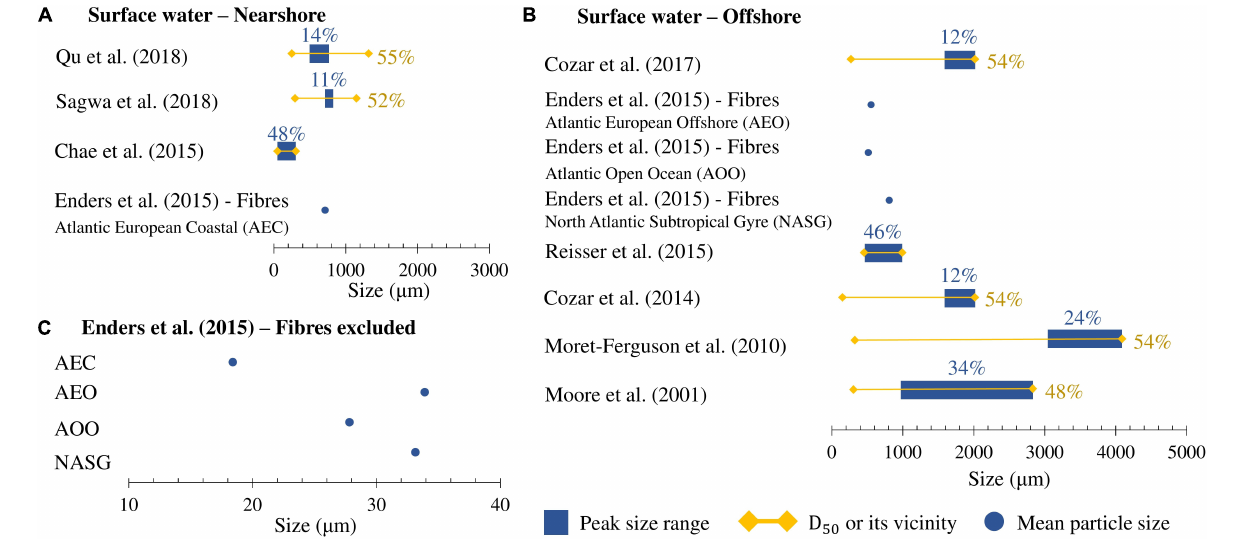
FIGURE 4 | Size distribution characteristics for surface water sample (A) nearshore and (B) offshore. (C) The mean size for MP particles excluding fibers by Enders et al. (2015). The box in each study identifies the size bin with the highest concentration. The size of the box is unique in each study and is consistent with the bin size reported. The horizontal bar in each study is the D 50 or its proximity. Since bin sizes vary among these studies, D 50 is determined within ± 5%. The circles are the average MP size presented by selected studies, where size distribution was available but could not be